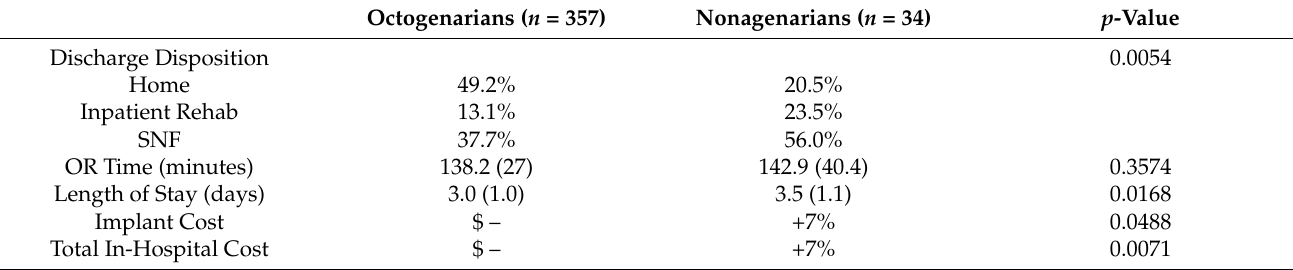
Table 2. Comparing outcomes and costs for total hip arthroplasty between octogenarians and nonagenarians. SNF = skilled nursing facility. OR = operating room.